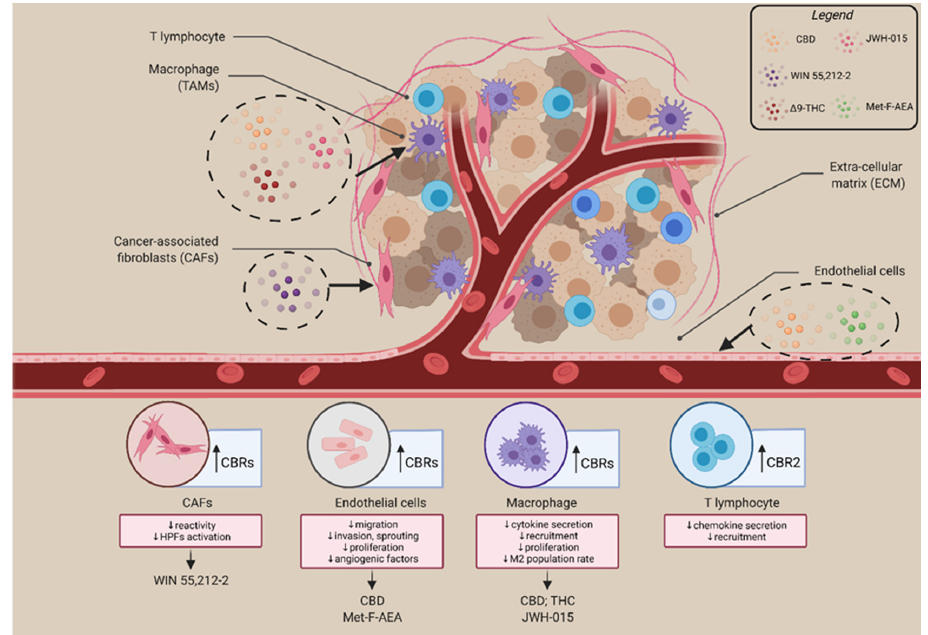
Figure 4. ECS re-shape TME by regulating the functionality and reactivity of different cellular components. Several TME cells express receptors of the ECS; particularly, immune cells, CAFs, and endothelial cells. Cannabinoids are able to mediate several anticancer mechanisms; these bioactive lipids reduce cytokine secretion, T-cell recruitment, proliferation, M2 population rate, thus acting on immune components; reduce CAFs reactivity and invasive ability. On endothelial cells, cannabinoids act on migration, invasion, sprouting features and reduce angiogenic factors release. Cannabinoids showed in the figure: CBD, WIN 55,212-2, Δ 9-THC, JWH-015, Met-F-AEA. Created with BioRender.com. Adapted from “Tumor Microenvironment” template, accessed on 16 November 2021.